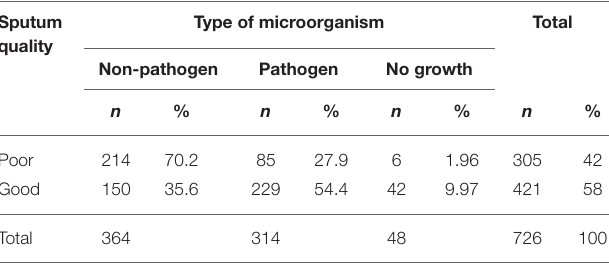
TABLE 2 | Distribution of total isolated microorganism from good and poor-quality sputum specimen from January to June 2018 in Tertiary Sanglah Referral Hospital in Bali,